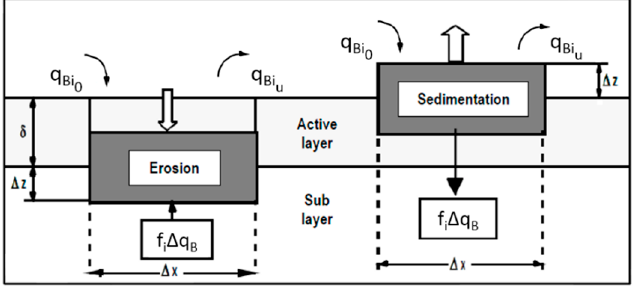
Figure 3. Model concept of an active layer according to Hirano.